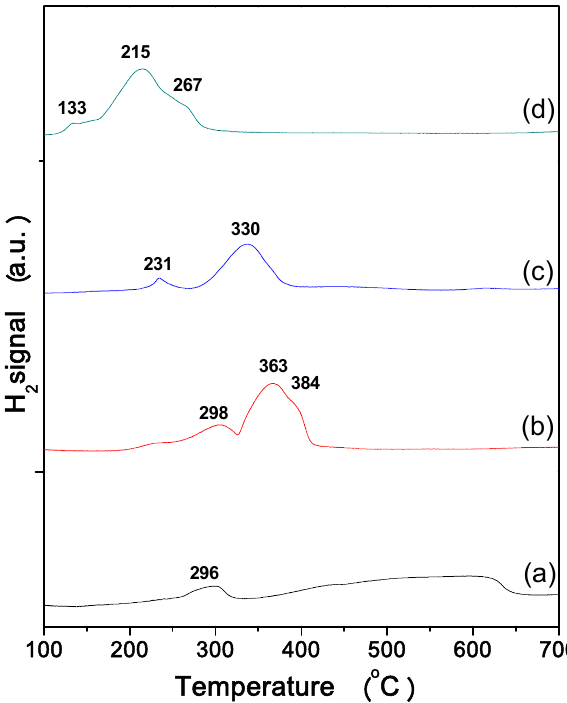
Figure 2. Temperature programmed reduction profiles of 20 wt.% Fe (a), Co (b), Ni (c) and Cu (d) catalysts supported on CeO 2 .